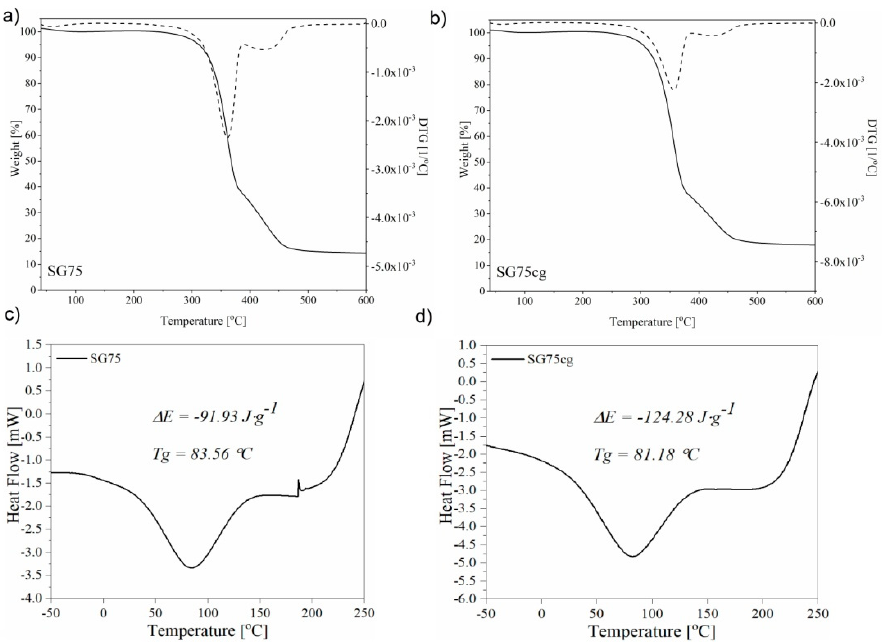
Figure 12. Effect of keratin modification on TG-DTG starch composites: SG75 ( a ), SG75cg ( b ). Effect of casein and gelatin biopolymers on DSC of starch composites: SG75 ( c ), SG75cg ( d ).